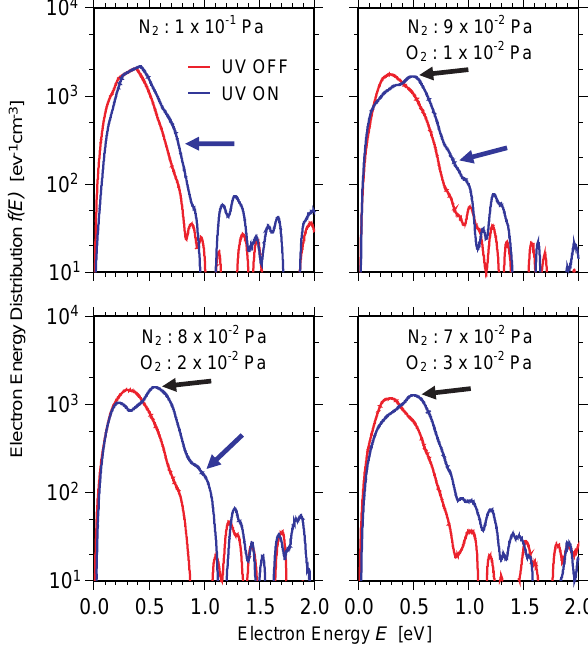
Fig. 5a. Second harmonic components under the N 2 /O 2 gas mix- ture. Right of the top panel shows the case when N 2 and O 2 gas pressure are 9 × 10 − 2 Pa and 1 × 10 − 2 Pa, respectively. The left and right panels at the bottom are for the 2 × 10 − 2 Pa and 3 × 10 − 2 Pa of O 2 , respectively. N 2 pressures are 8 × 10 − 2 and 7 × 10 − 2 Pa for each panel so that total pressure inside the test chamber is kept constant at 10 − 1 Pa. Red and blue lines show the second harmonic components without and with radiation of EUV. To compare the shape of the second harmonic component, the second harmonic component of only N 2 gas plasma is shown at the left of the top panel. Black and blue colored arrows indicate the energies where humps appear. Two short tip marks between two 10 increment-long tip marks indicate 2, and 5 respectively.